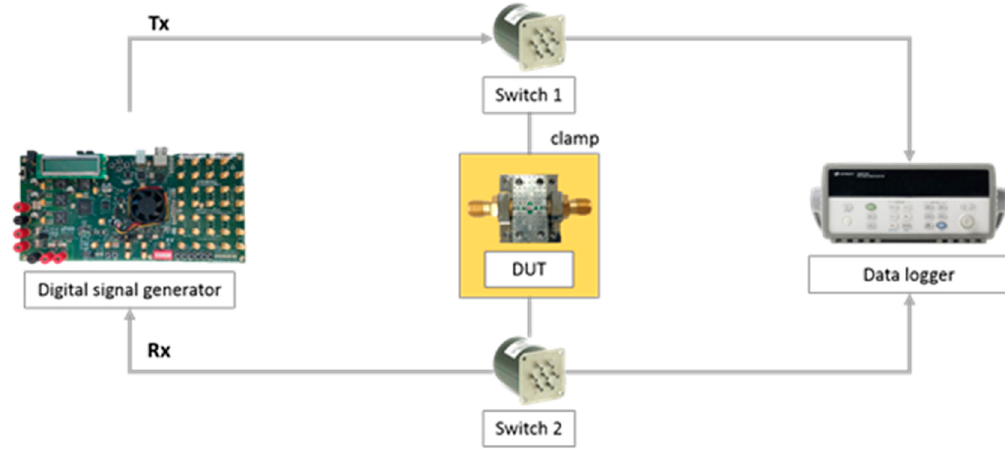
Figure 8. Test board and test fixture used in the accelerated life test. ( a ) test board ( b ) schematic of the test environment.